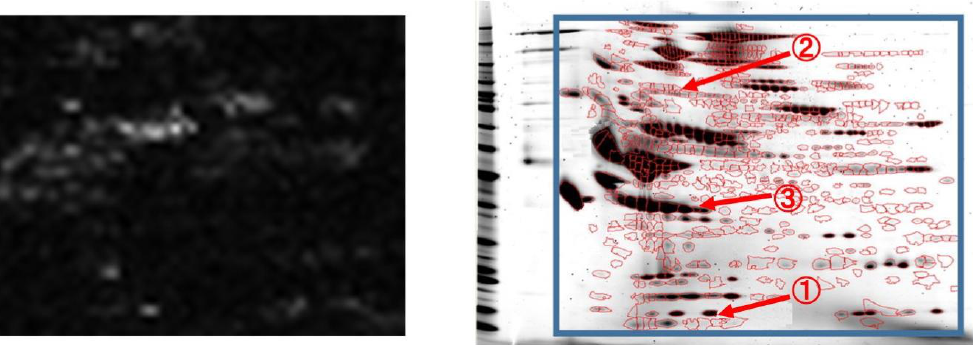
Figure 4. Visualization of weight. Red circles show examples of currently known valid spots. Blue frame represents the position of the weight image. 1: Transthyretin [21], 2: Ceruloplasmin [22], 3: Prothrombin [23].